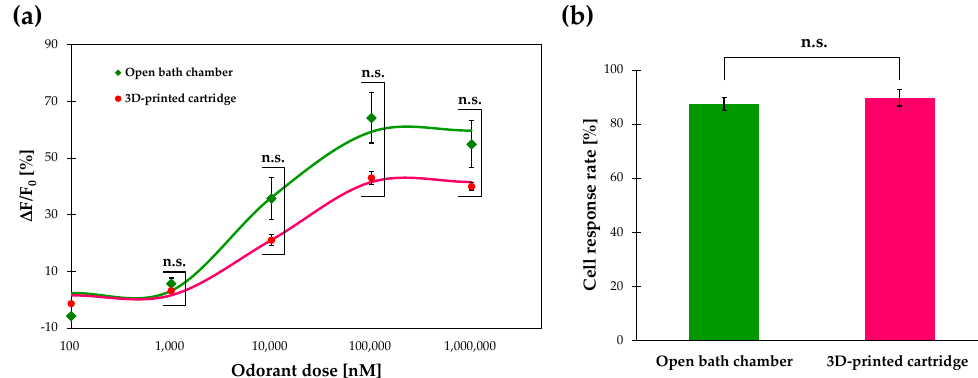
Figure 4. ( a ) Comparison between average dose-dependent response of Or13a cells in the 3D-printed cartridge with a 20× objective lens and in a commercial open bath camber with a 20× water-immersion objective lens previously used for Sf21 cells expressing insect ORs. The data represent the mean ± standard error of the mean (SEM) of the fluorescence intensity changes in all cells ( N = 4 individual tests, Welch’s t -test; n.s. = not significant). ( b ) Comparisons of the cell-response rates in the 3D-printed cartridge and a commercial open bath chamber exhibited greater than 5% increase in fluorescence intensity during 10 μ M 1-octen-3-ol stimulation. Data represent the mean ± SEM of fluorescence intensity changes of Or13a cells ( N = 4 individual tests, Welch’s t -test: n.s., not significant).